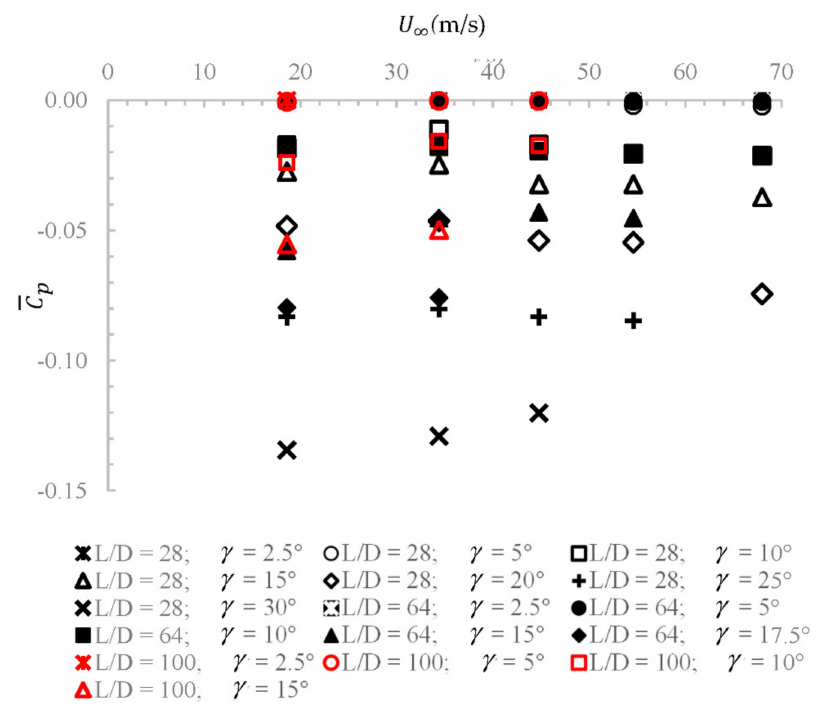
Figure 4. Average pressure coefficient around the cylinder, C p , as a function of the freestream velocity, U ∞ , for the three different cylinders and range of γ